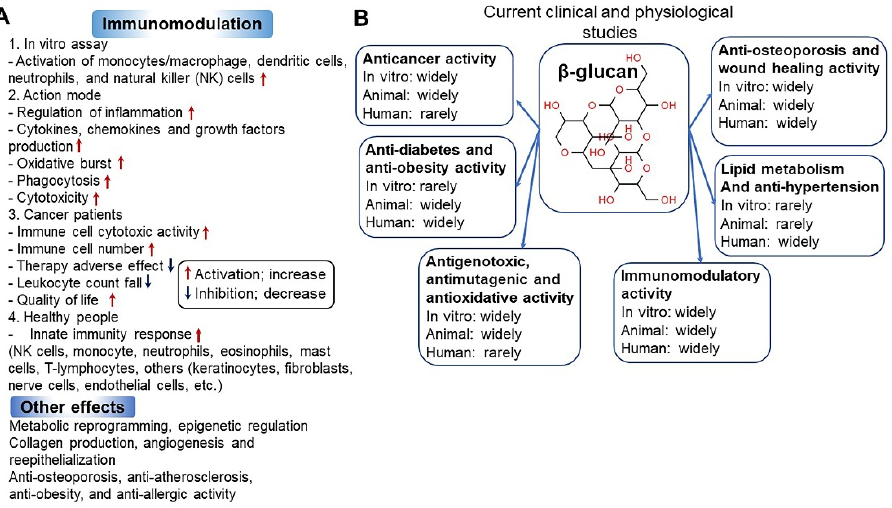
Figure 4. Immunomodulatory activity ( A ) [57] and clinical and physiological perspectives ( B ) [58] of β -glucan.